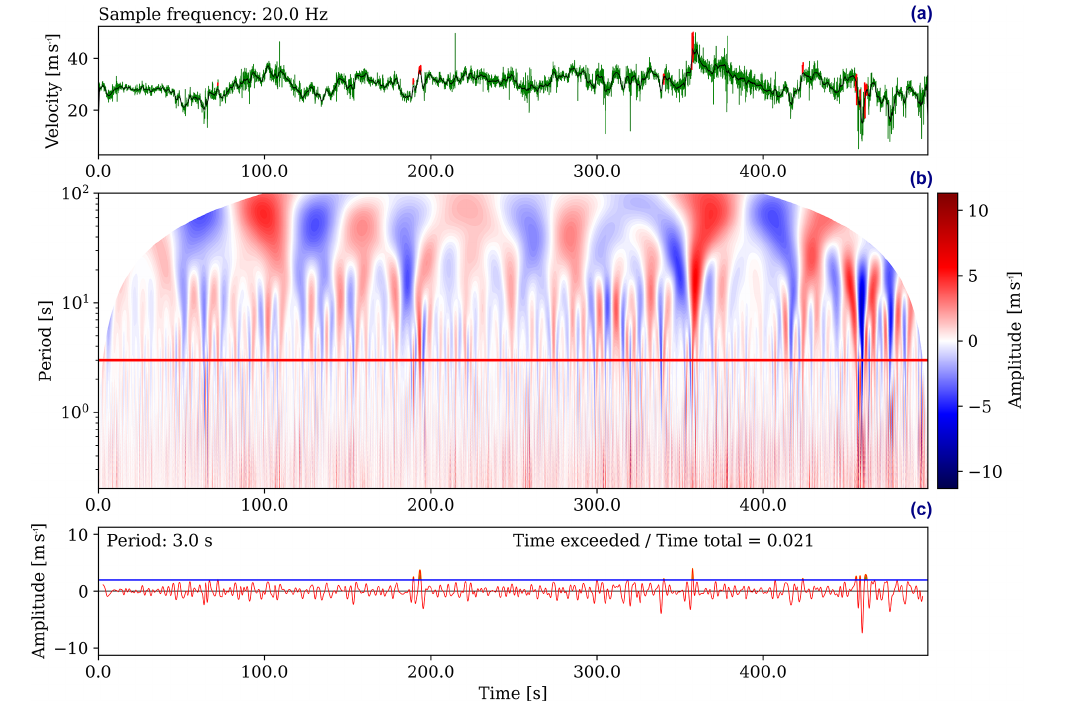
Figure 1. (a) shows a 500s long portion of turbulence-resolving wind velocity data (green) taken from mast-measurements at the Hamburg Weather Mast. The running mean with a window of 3s is shown in black and detected gusts are marked in red. (b) shows the 2-D contour of wind velocity amplitudes A n ( T ) over a period range from 0.2 to 100s. The color contour represents amplitudes contained in the wind velocity data depending on time and period. The white masked-out area within (b) is the COI. (c) shows wind velocity amplitudes A n ( T ) for the distinct period of 3s along the horizontal red line in (b) . The blue line in (c) marks an amplitude of 2ms − 1 . About 2.1% of the investigated time series contains gusts that have a period of 2s and an amplitude that matches or exceeds 2ms − 1 . Note that an amplitude of 2ms − 1 means signal value changes of 4ms − 1